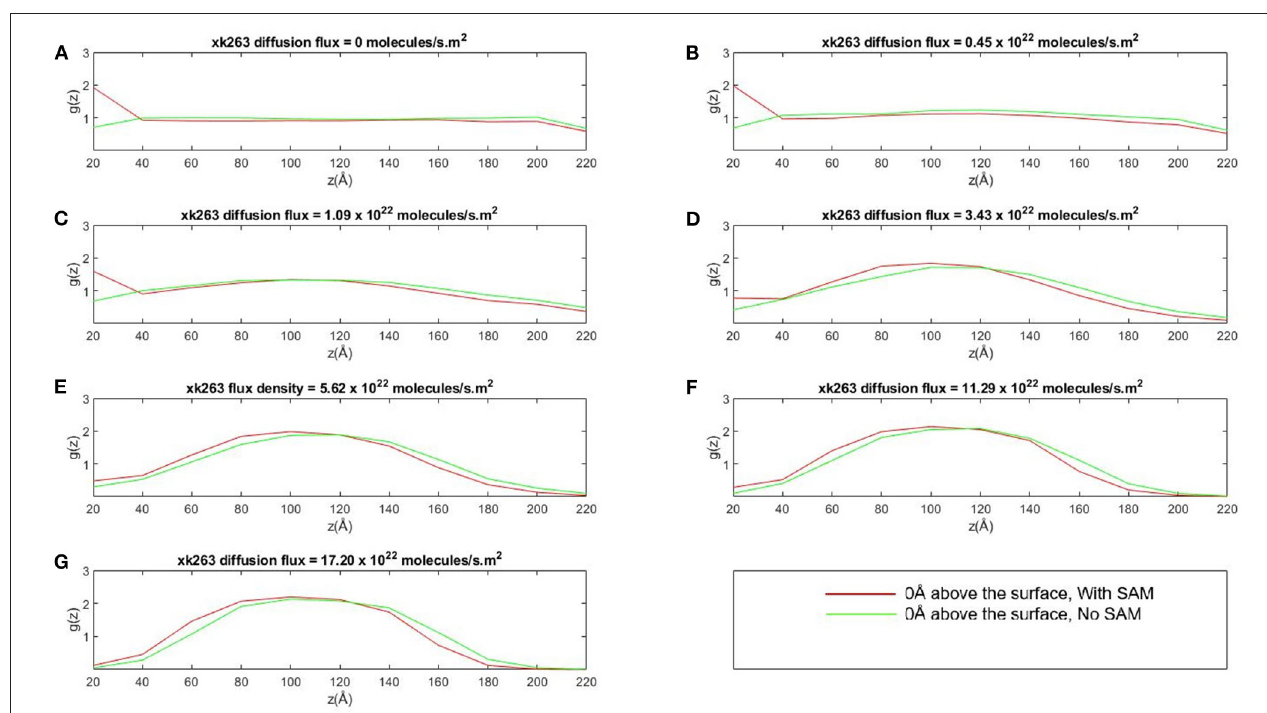
FIGURE 6 | Plot of concentration distribution of xk263, g(z), as a function of the distance above the CH 3 -SAM, z, in seven different diffusion fluxes (A–G) . The space was partitioned into equally sized slices with a height of 20 Å. g(z) is the ratio of number of observed xk263 and the number of expected xk263 approximated from a random diffusional